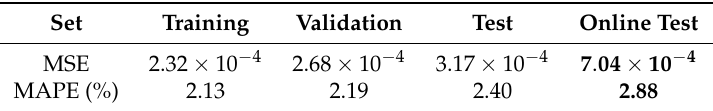
Table 1. Results from the training and validation of the Nonlinear Autoregressive model with MSE: Mean Squared